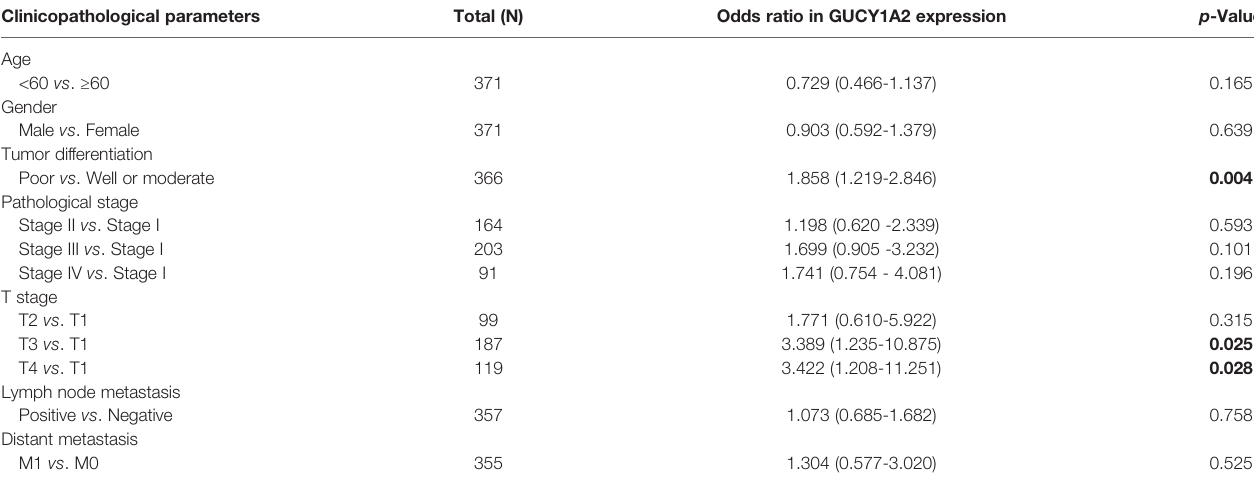
TABLE 1 | Relationships between GUCY1A2 expression and clinicopathological parameters of GC patients. Clinicopathological parameters